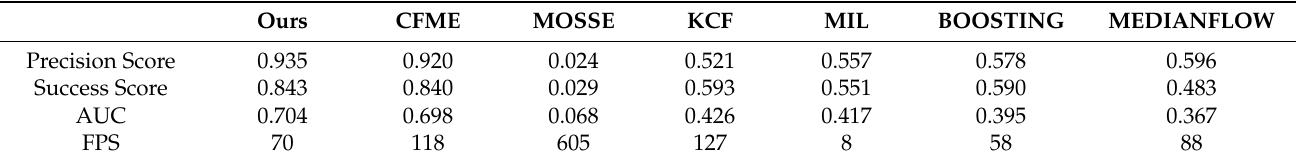
Figure 9. Precision plot and success plot. The values in legends are the AUC. ( a ) Precision plot of video3. ( b ) Success plot of video3. Table 5. Results of video3.